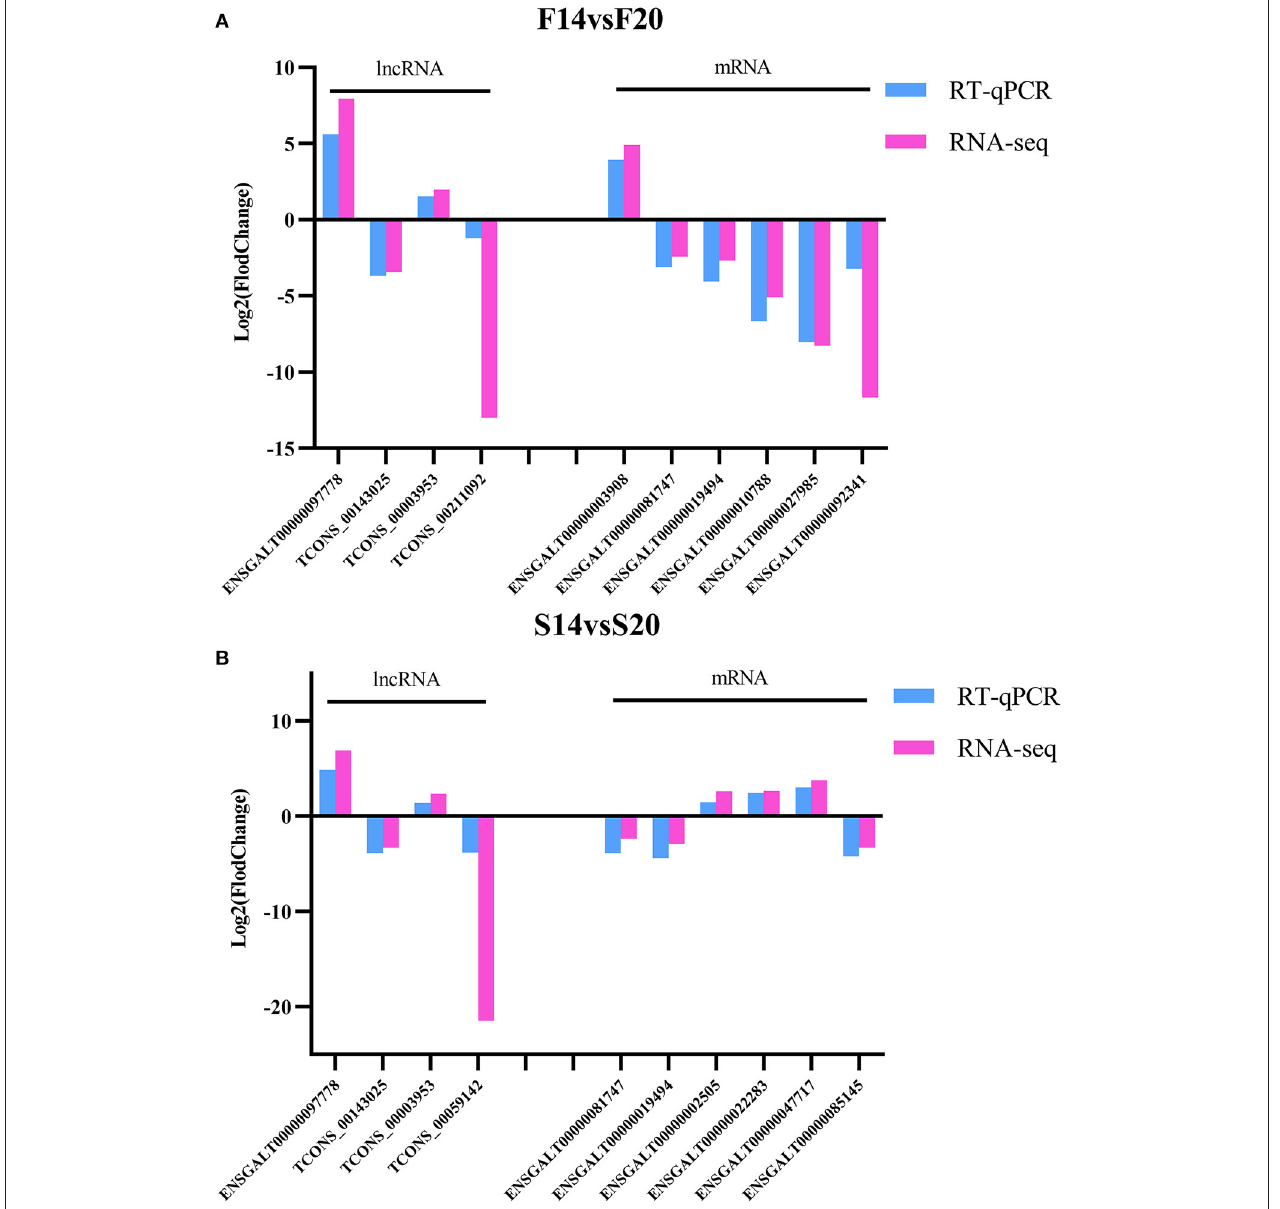
FIGURE 8 | Validation for the results of RNA-seq. (A) DE lncRNAs and mRNAs for F14vsF20 comparison group; (B) DE lncRNAs and mRNAs for S14vsS20 comparison